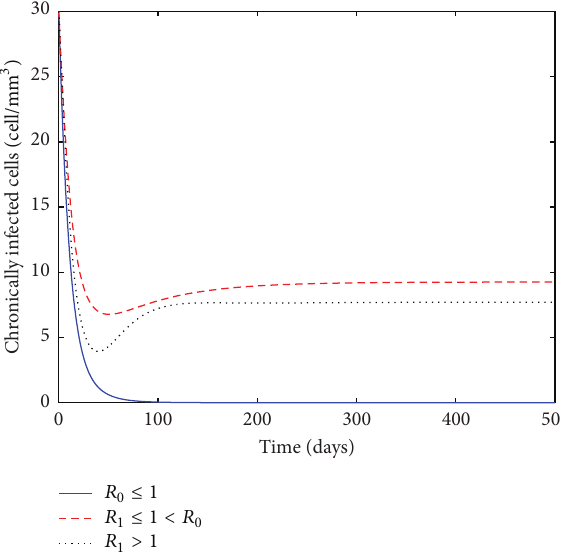
Figure 6: The evolution of uninfected cells for model (33)–(37).